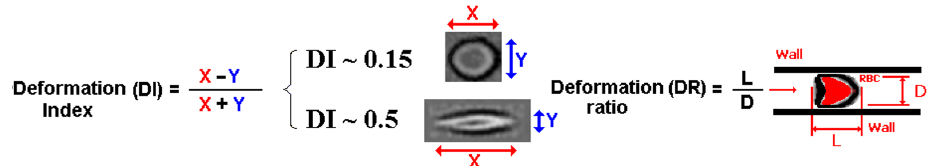
Figure 2. Schematic diagram of the deformation index (DI) and deformation ratio (DR) definition, adapted from [17].